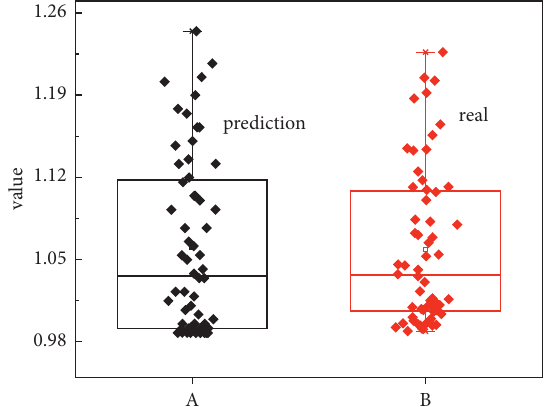
Figure 7: The box distribution diagram of predicted value and actual value of financial risk level.